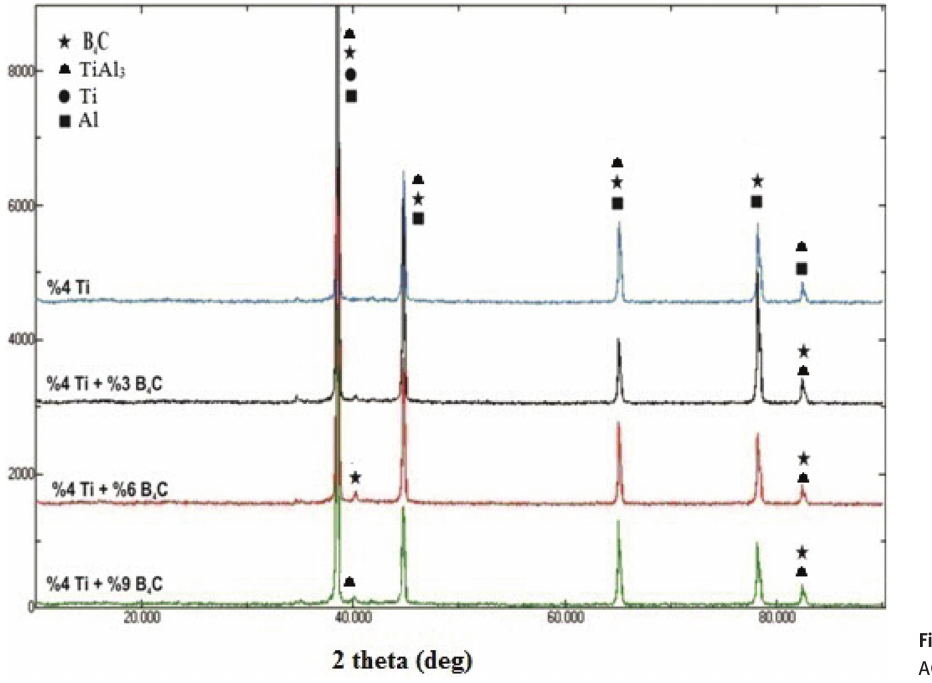
Figure 2: XRD results of hybrid ACMs.